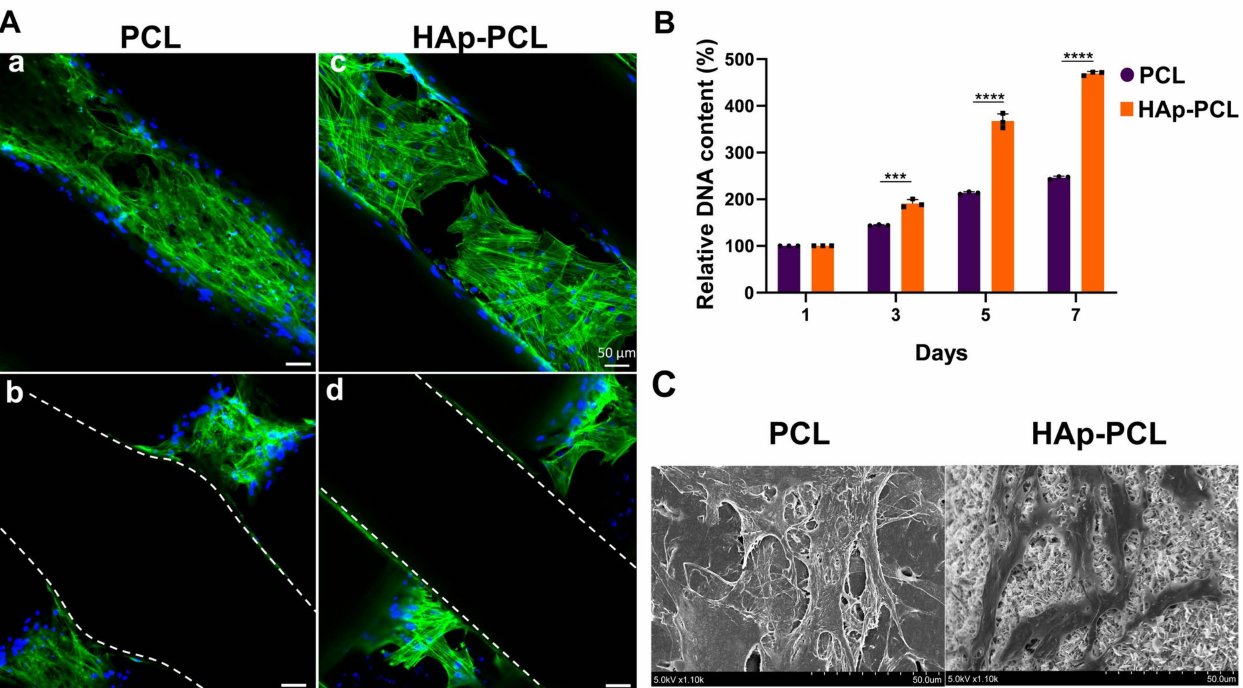
Figure 4. The behavior of rBMSCs on PCL-based scaffolds. ( A ) Fluorescent microscopic images of rBMSCs 24 h after culturing on PCL ( a , b ) or HAp-PCL ( c , d ). Images were acquired in the outermost ( a , c ) and interior ( b , d ) planes. The region between the dashed lines indicates a fiber of the scaffold. Actin filaments and nucleus were stained and are indicated in green and blue, respectively. Scale bar is 50 µ m. ( B ) Time profiles of relative DNA content of BMSCs cultured on PCL or HAp-PCL. *** p < 0.001, **** p < 0.0001: significant difference between two groups at the corresponding time. ( C ) SEM images of rBMSCs cultured on PCL or HAp-PCL for 3